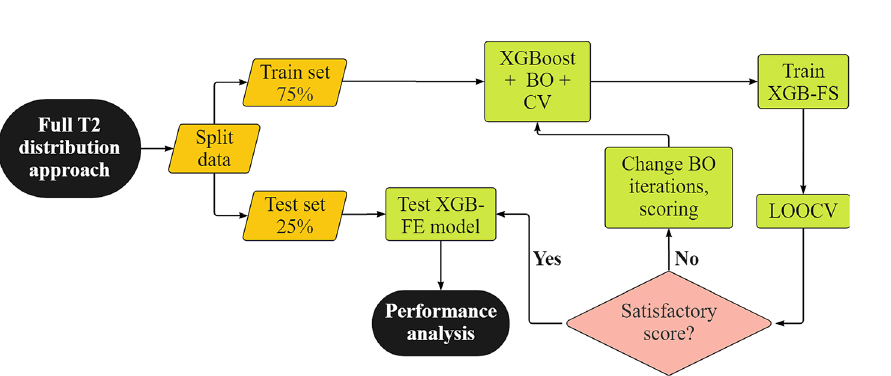
Figure 7. Flowchart for XGB-FS model development.